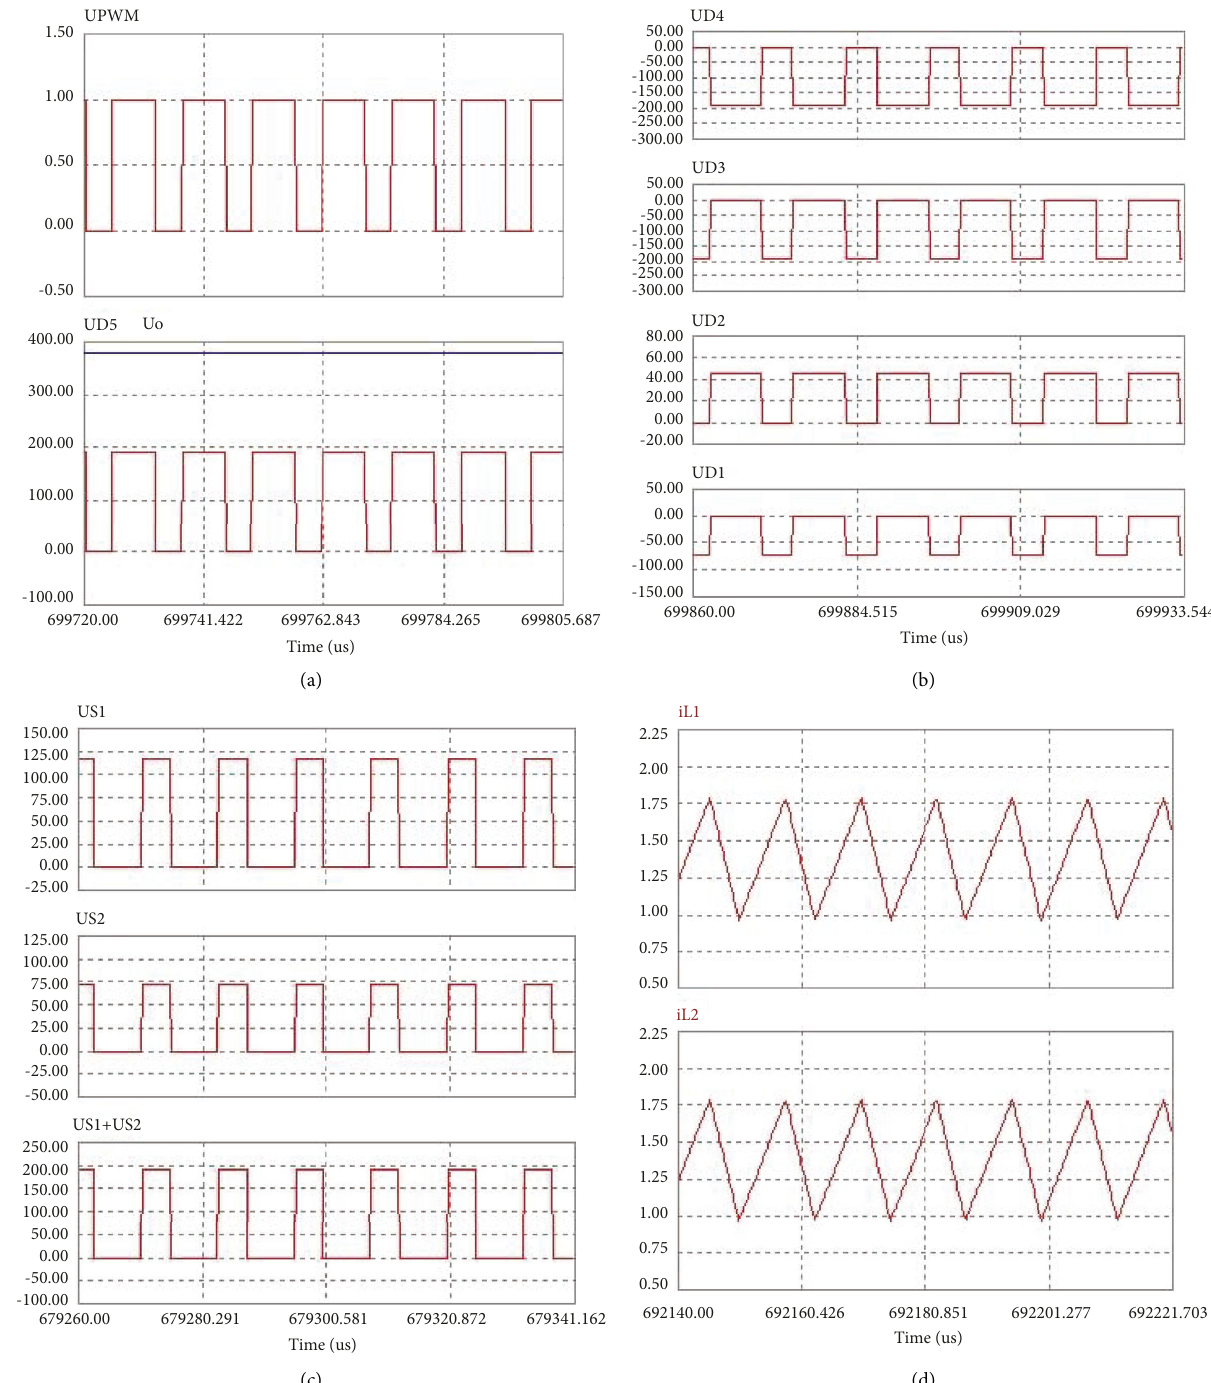
Figure 13: Simulation results when V currents of L 1 and L 2